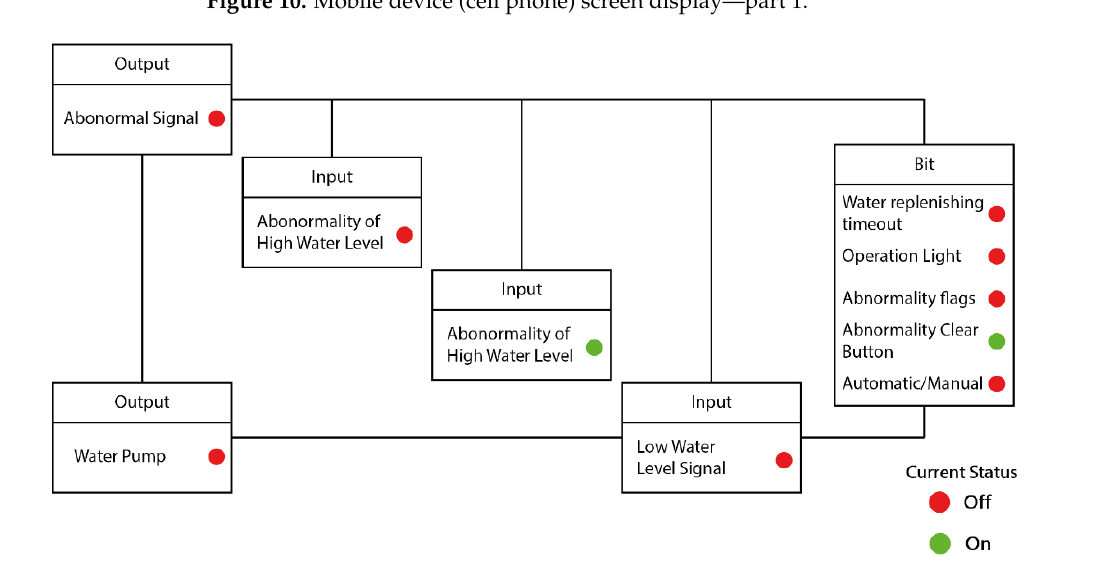
Figure 11. Mobile device (cell phone) screen display—part 2.